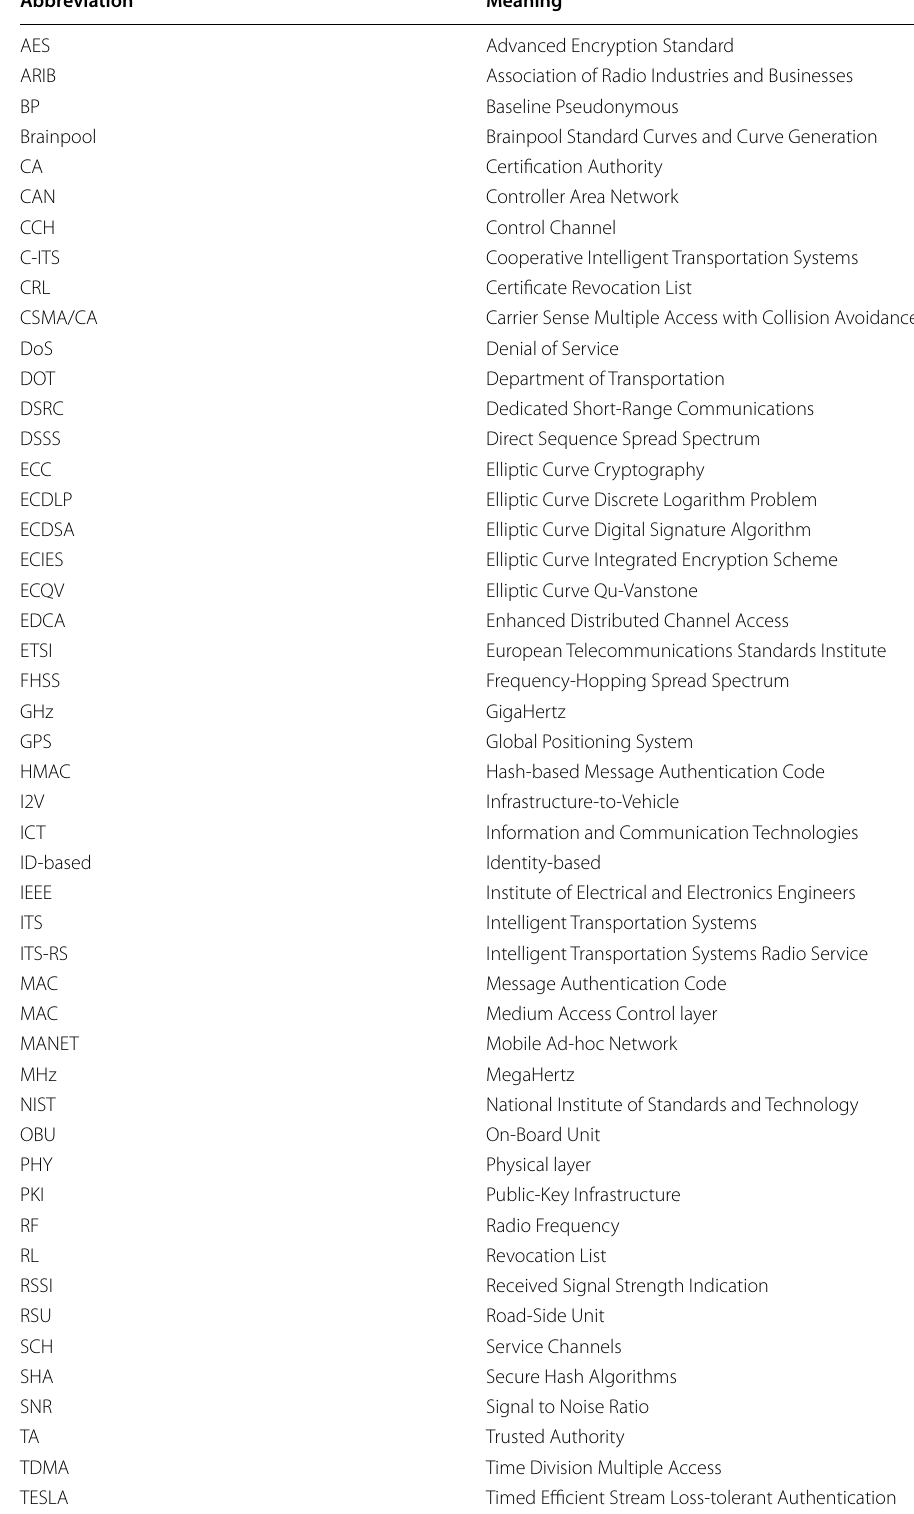
Table 1 List of